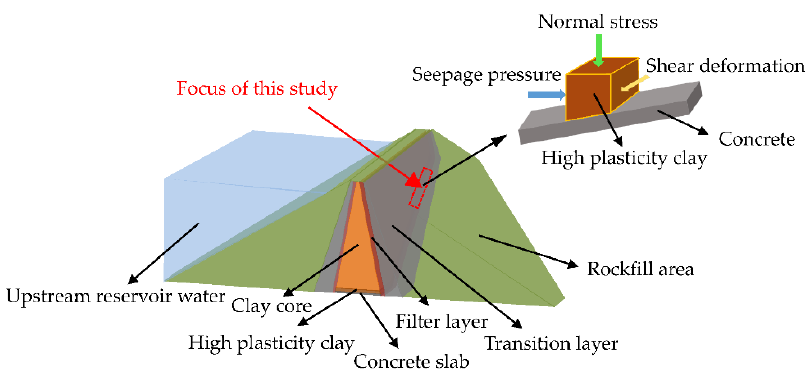
Figure 1. Working condition of clay–structure interface in high clay–core rockfill dams.